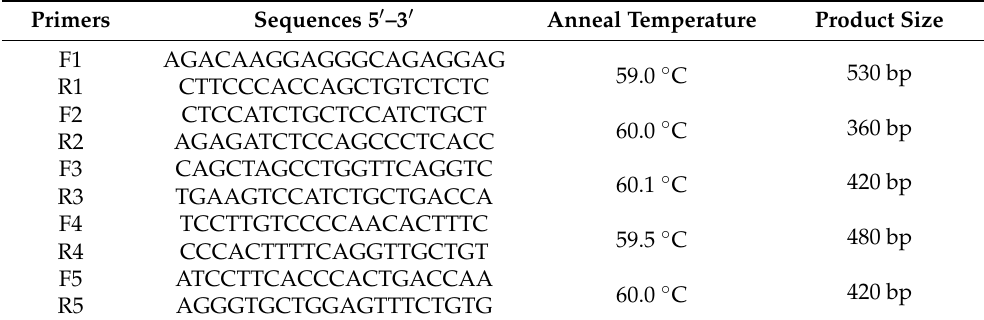
Table 1. Primers and annealing temperatures used for PCRs of the porcine NK-lysin ( NKL )